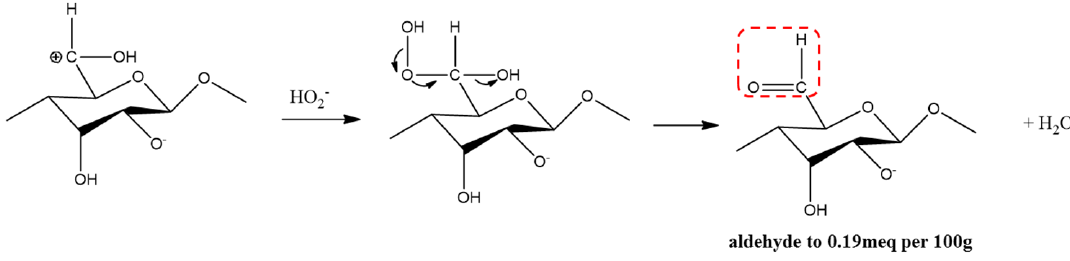
Figure 8. The oxidation to aldehyde.